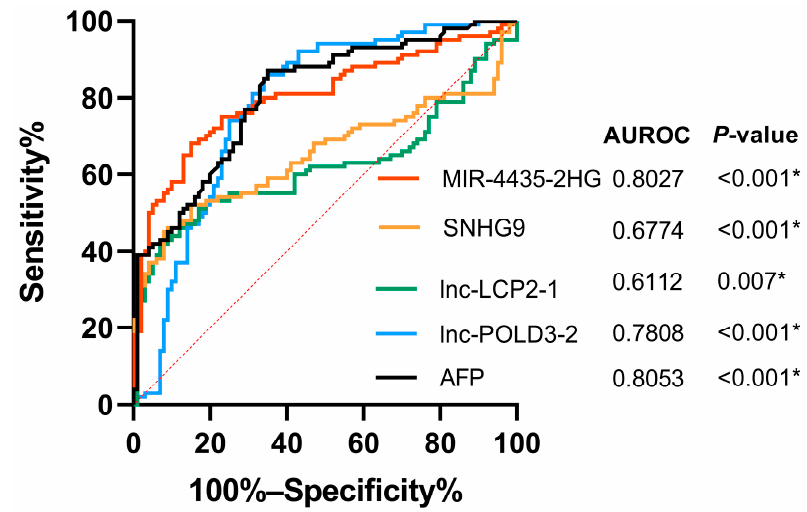
Figure 3. Area under receiver operating characteristic curves (AUROCs) of lncRNAs and AFP for differentiating the HCC group from the non-HCC group.